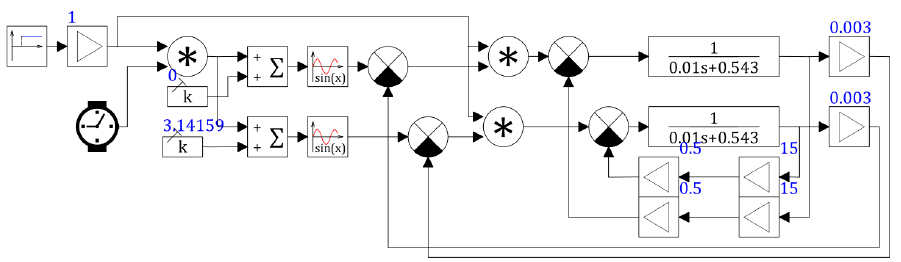
Table 2. Generator parameters [40].